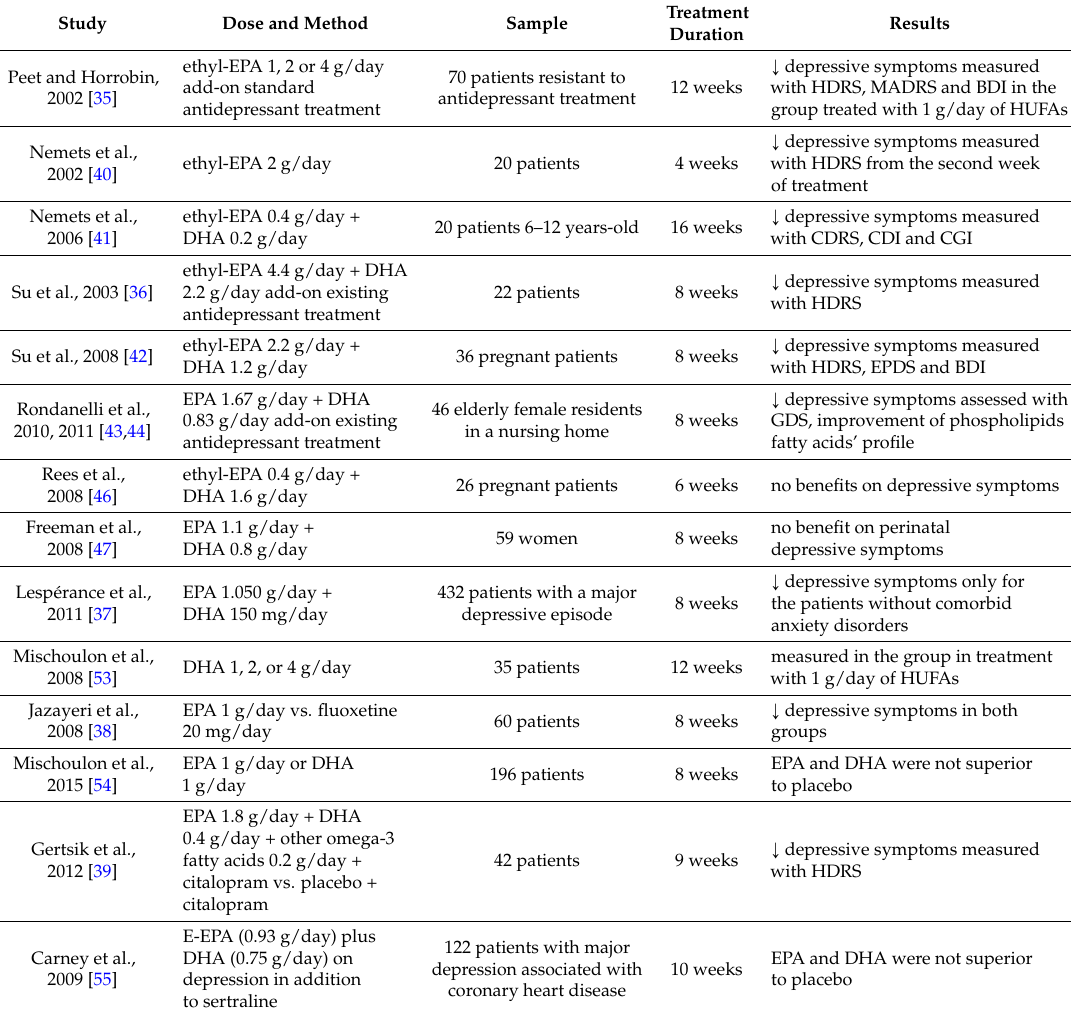
Table 2. Double-blind controlled trials of HUFAs in the treatment of depressive disorders. HDRS, Hamilton Depression Rating Scale; MADRS, Montgomery-Åsberg Depression Rating